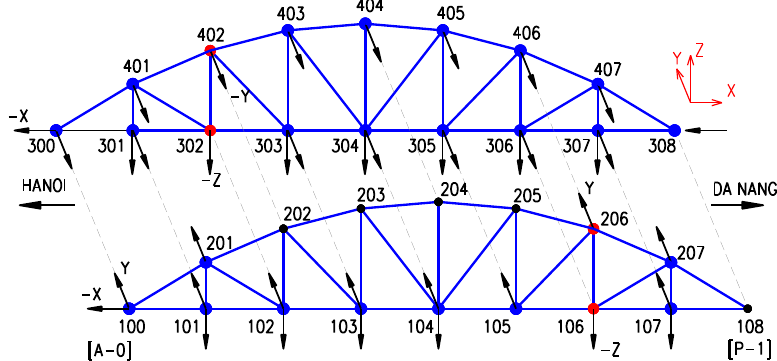
Figure 3. The measurement grid: accelerometers at 40 DOF; red: reference points – 106, 206, 302, and 402; blue: roving points.